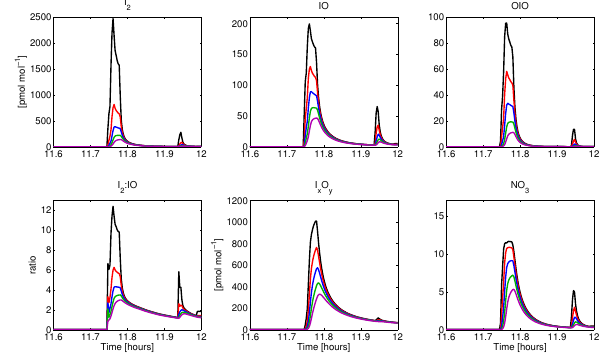
Fig. 9. Mixing ratios of I 2 , IO, OIO, I x O y , NO 3 , and ratio of I 2 :IO, in the lowest five layers of the model column for the base case, low tide, model run. Black, red, blue, green, and purple lines represent levels with their centres at 0.5, 2, 4.5, 8 and 12.5m, respectively.